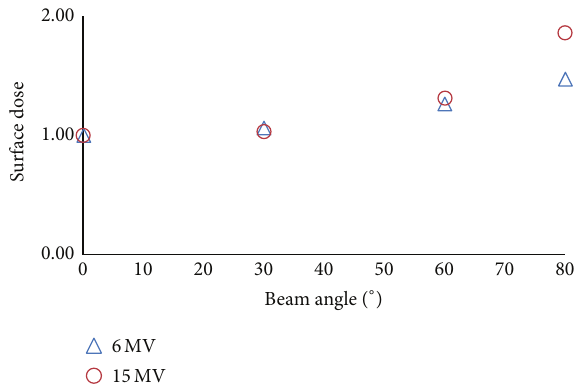
Figure 7: The angular dependence of the epoxy side of the MOSFET dosimeter for 6 MV and 15